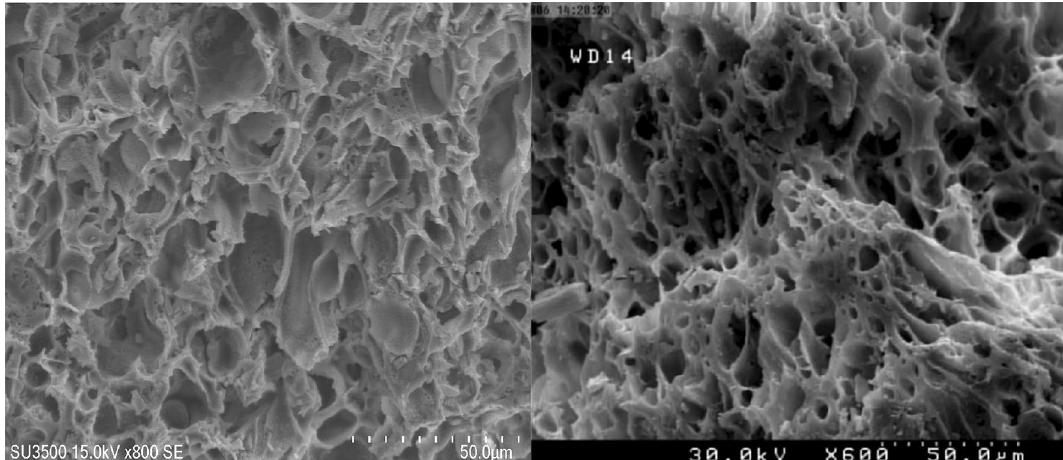
Figure 1. SEM graphs of pumice adsorbent.